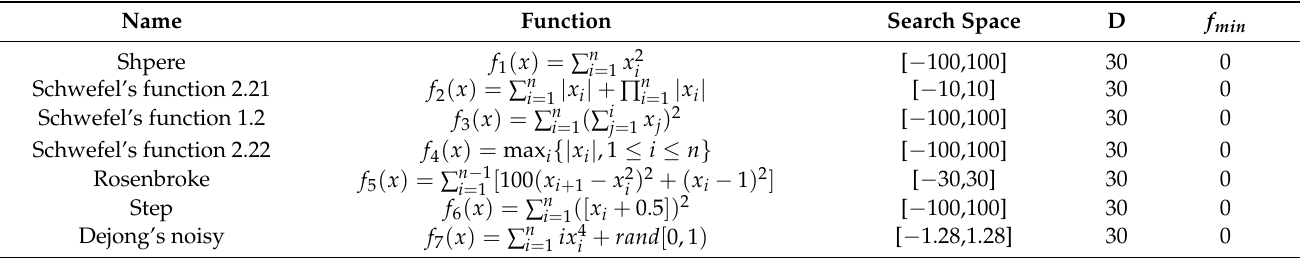
Table 10. Unimodal benchmark functions.